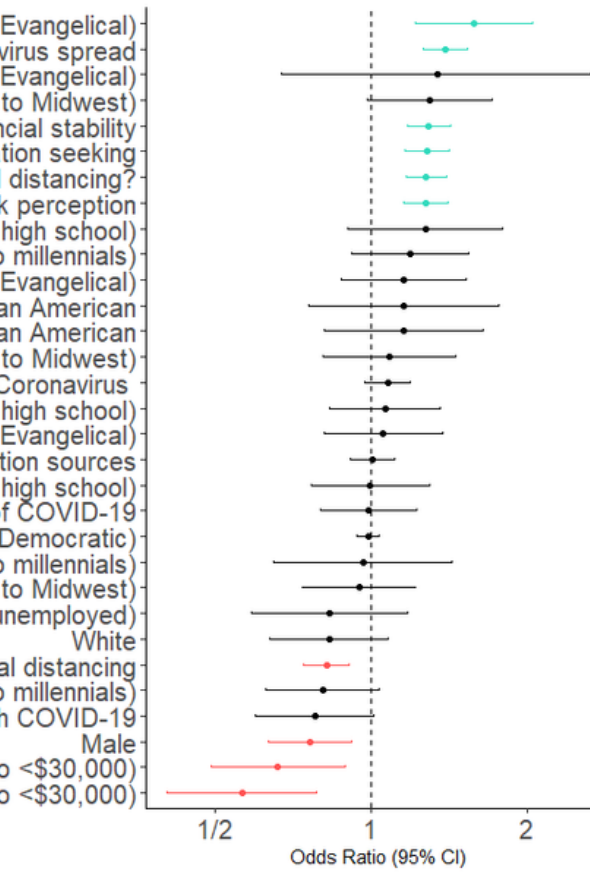
Figure 2. Observational odds ratios of predictors on social distancing with 95% confidence intervals. Variables in red are negatively associated with social distancing; variables in cyan are positively associated with social distancing, at a cut-off of p < .05 uncorrected for multiple comparisons. Variables in black have no statistically significant relationship with social distancing behavior. All linear variables have been standardized so that the odds ratio reflects the difference in shifting one standard deviation from the mean on that In addition to demographic characteristics, some of the strongest predictors of social distancing behavior were related to perceptions and beliefs. Specifically, respondents who were more likely to social distance included those who believed they could help prevent the spread of coronavirus (OR = 1.27; 95% CI = 1.18–1.36; p < .001), those with higher risk perceptions around the negative health consequences of not social distancing (OR = 1.07; 95% CI = 1.04–1.11; p < .001), those who perceived strong community norms toward social distancing